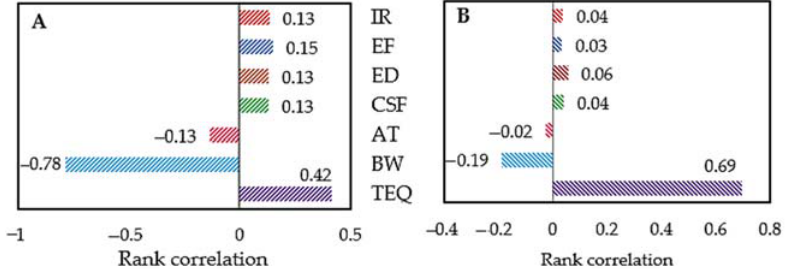
Figure 4. Sensitivity analysis of carcinogenic risk for exposed children ( A ) and comparative chil ‐ dren ( B ). dren ( B